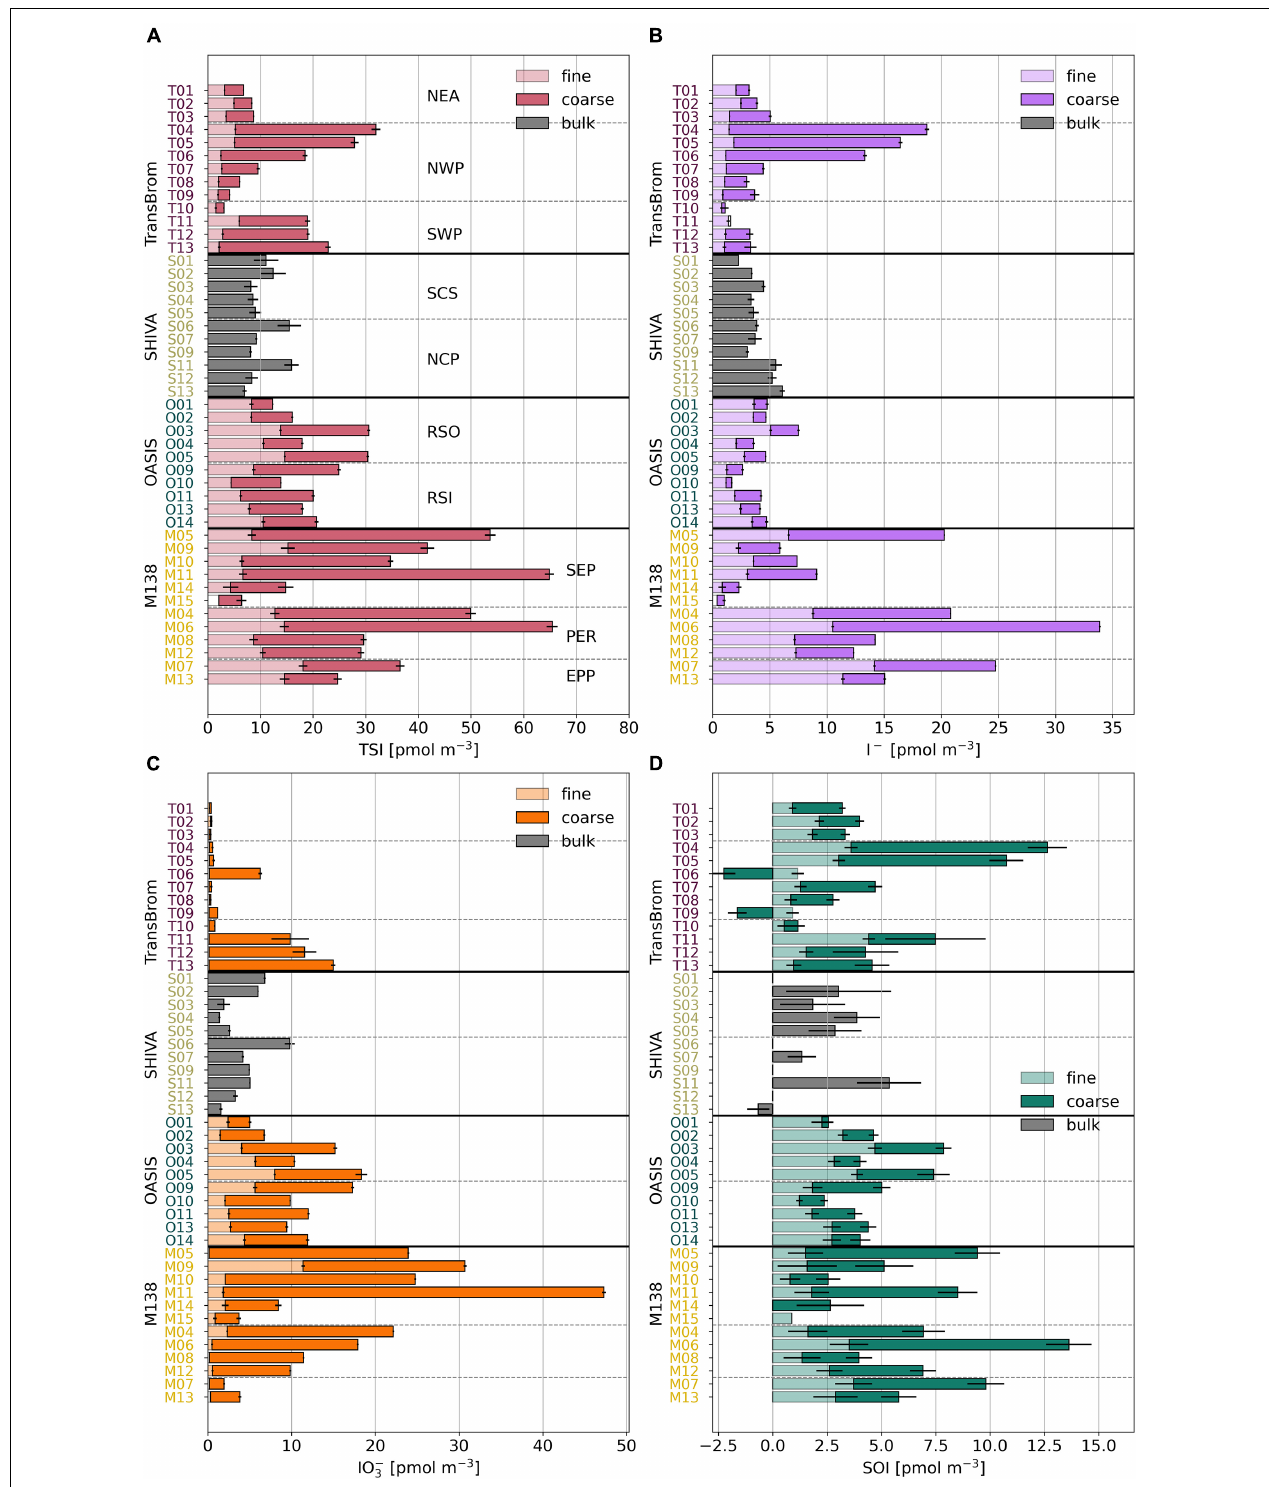
FIGURE 4 | Bar plots of TSI (A) , I - (B) , IO 3 - (C) , and SOI (D) concentrations in fine (light), coarse (dark), and bulk (grey) mode for TransBrom, OASIS, M138, and SHIVA aerosol samples. Empty bars indicate concentrations below the detection limit. SOI concentrations for which the error is larger than the parameter itself are omitted. Details are as for Figure 3